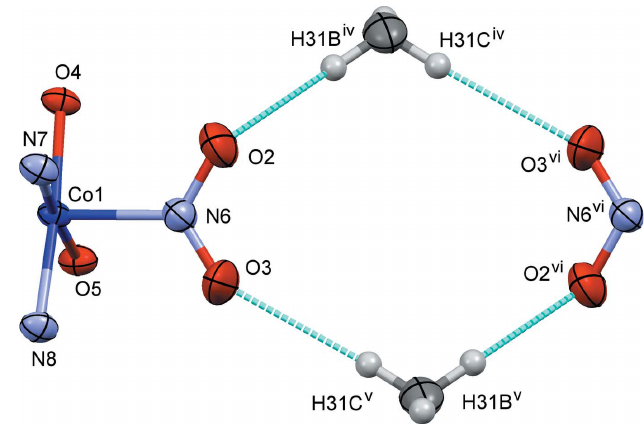
Figure 7 The steric circumstance of the nitro group in (II). Only parts of the complex are shown for clarity. The C—H (cid:2)(cid:2)(cid:2) O hydrogen bonds are shown as blue dashed lines. Symmetry codes: (i) (cid:3) x + 1, (cid:3) y + 1, (cid:3) z + 1; (ii) (cid:3) x + 1, y (cid:3) 1 , (cid:3) z + 3 ; (iii) x + 1, (cid:3) y + 1 2 2 x (cid:3) 1, (cid:3) y + 1 , z (cid:3) 1 ; (vi) (cid:3) x , 1 (cid:3) y , 1 (cid:3) z 2 2